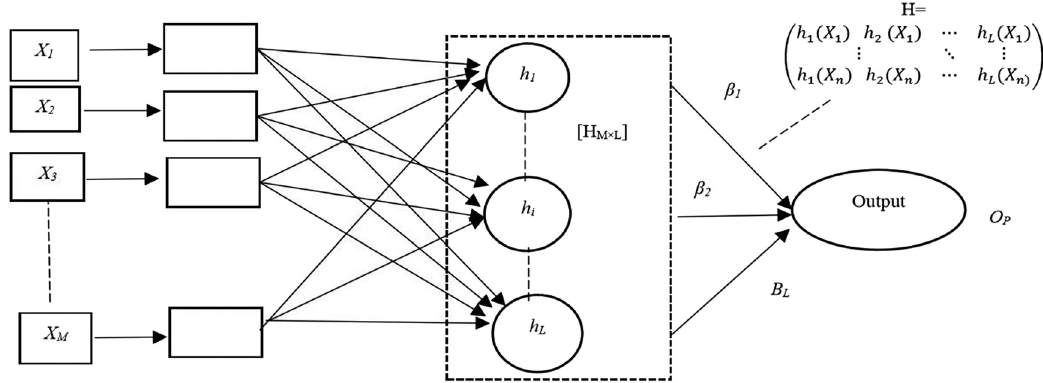
Figure 3: The basic architecture of